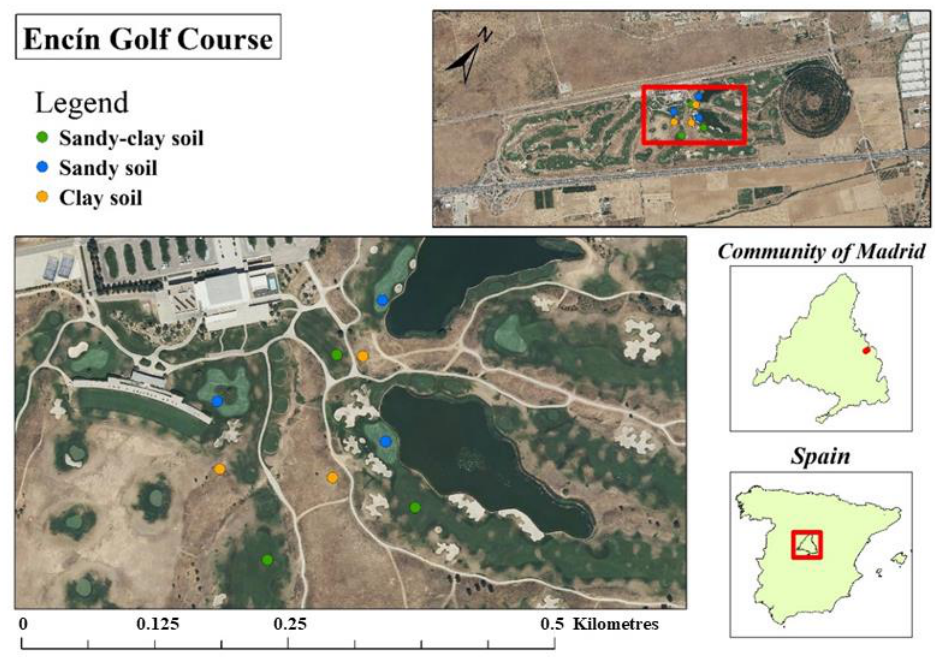
Figure 1. “Encín” Golf Course (Alcalá de Henares, Madrid, Spain) and sensors location. Figure 1. “Enc í n” Golf Course (Alcal á de Henares, Madrid, Spain) and sensors